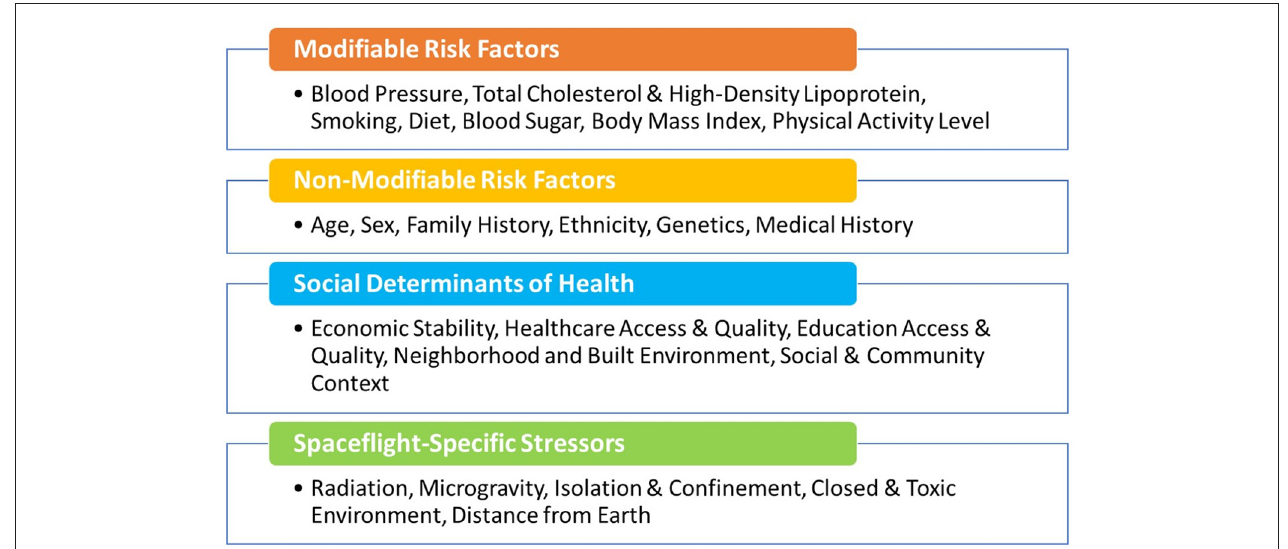
FIGURE 1 | Modifiable and non-modifiable cardiovascular risk factors, including social determinants of health (25) and those unique to astronauts during space missions.